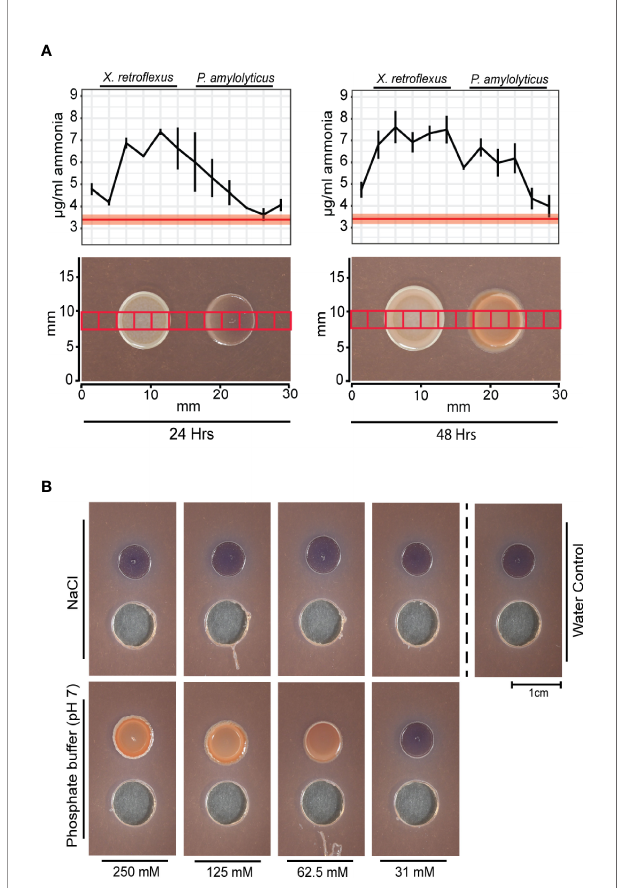
FIGURE 3 | The pH stabilized interaction of X. retro fl exus and P. amylolyticus . (A) Ammonia pro fi les measured over the interaction zone of X. retro fl exus and P. amylolyticus . 2.5 by 2.5 mm agar plugs were excised from the interaction zone according to the red squares overlayed in the morphology panel. The ammonia release was measured from each excised agar plug. Red line in the plot shows the mean ammonia concentration in control agar (50% TSA), with the red transparent ribbon indicating standard error of the mean (n=3). Black line represents mean ammonia concentration across the interaction zone, with horizontal bars indicating standard error of measured ammonia (n=3). At 24 hrs, ammonia released from X. retro fl exus formed a gradient across the P. amylolyticus colony. At 48 hrs the amount of ammonia increased in the interaction zone as well as over the P. amylolyticus colony. The images show the morphological changes of P. amylolyticus occurring from 24 hrs to 48 hrs. (B) Effect of pH buffering on the growth of P. amylolyticus . P. amylolyticus was cultivated for 48 hrs adjacent to wells containing 100 µL NaCl or phosphate buffer (pH 7) in concentrations ranging from 250-31 mM and with sterile MilliQ water as control. A morphological change of the P. amylolyticus colony was observed when adding buffer with increasing buffer capacity, whereas a similar salt concentration did not induce the morphological change. Individual plots with ammonia pro fi les for X. retro fl exus and P. amylolyticus are available as Figure S4